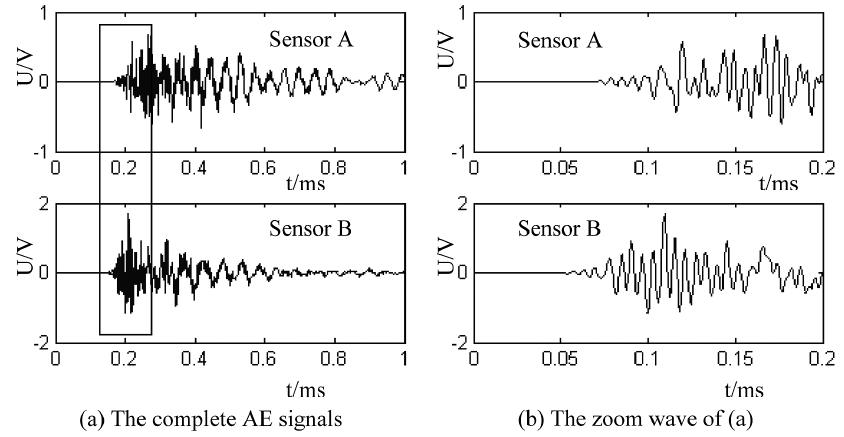
Fig. 4. The waveform of the pencil lead break AE signals.